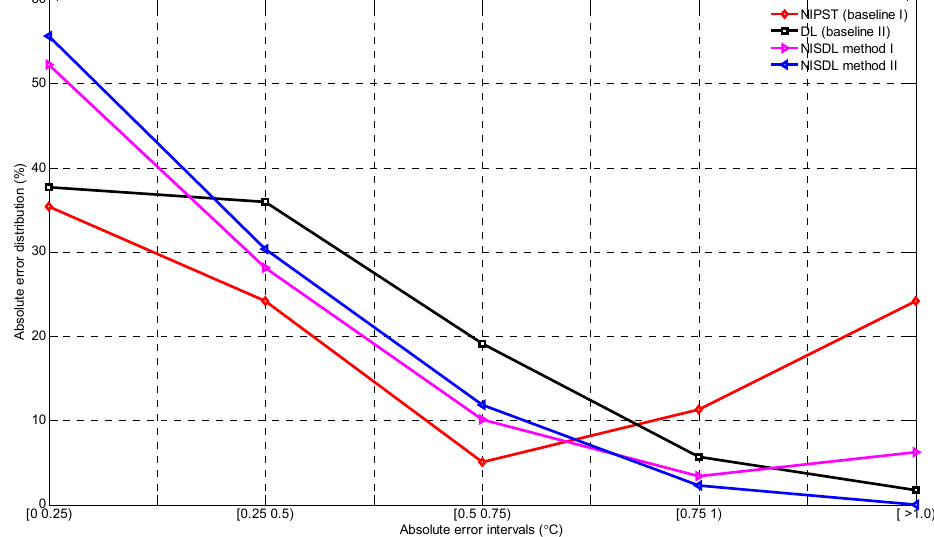
Figure 5. Error distribution comparison between baseline and NISDL ( a ). NIPST was published in [21]. ( b ). Skin images were used in training directly by DenseNet201 to obtain a model and predict skin temperature, and SSI was not involved. ( c ). NISDL method I and NISDL method II all belong to NISDL. The main difference is that SSI values and skin images are combined at different times.).